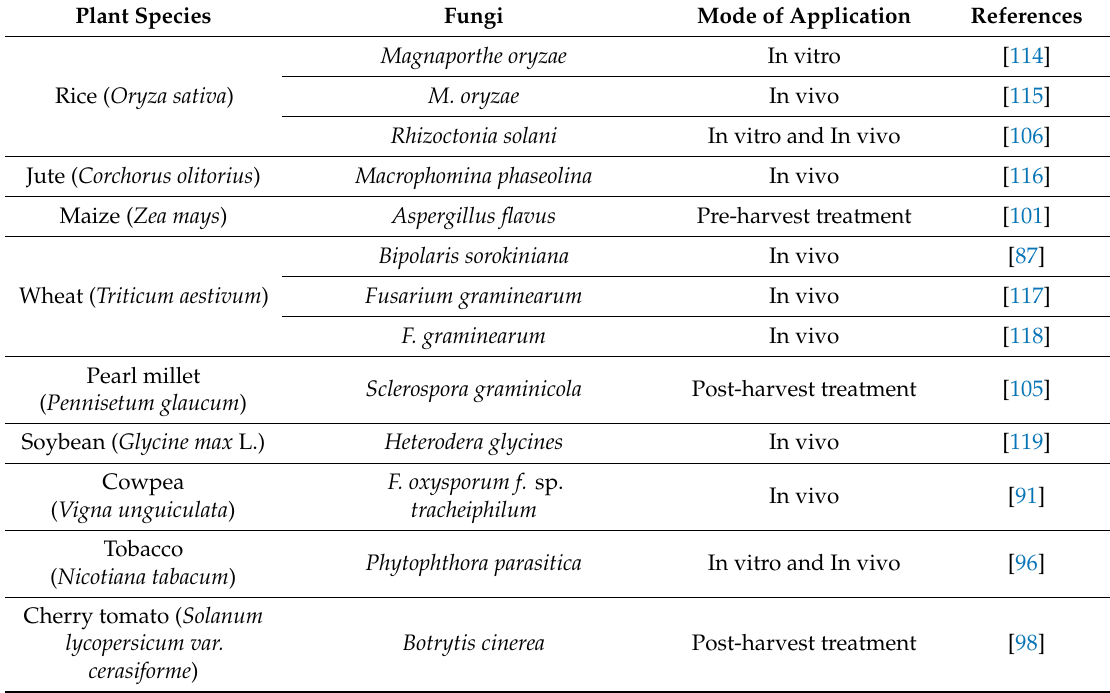
Table 2. E ff ects of CHT on fungal plant